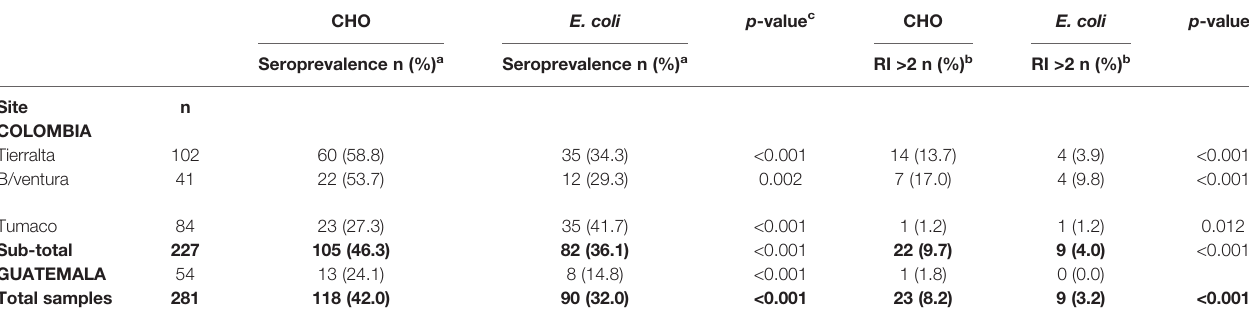
a Correspond to number and percentage of malaria exposed subjects. Percentage of positive responses: OD values above the negative control mean plus 3SD. Negative control: with no malaria